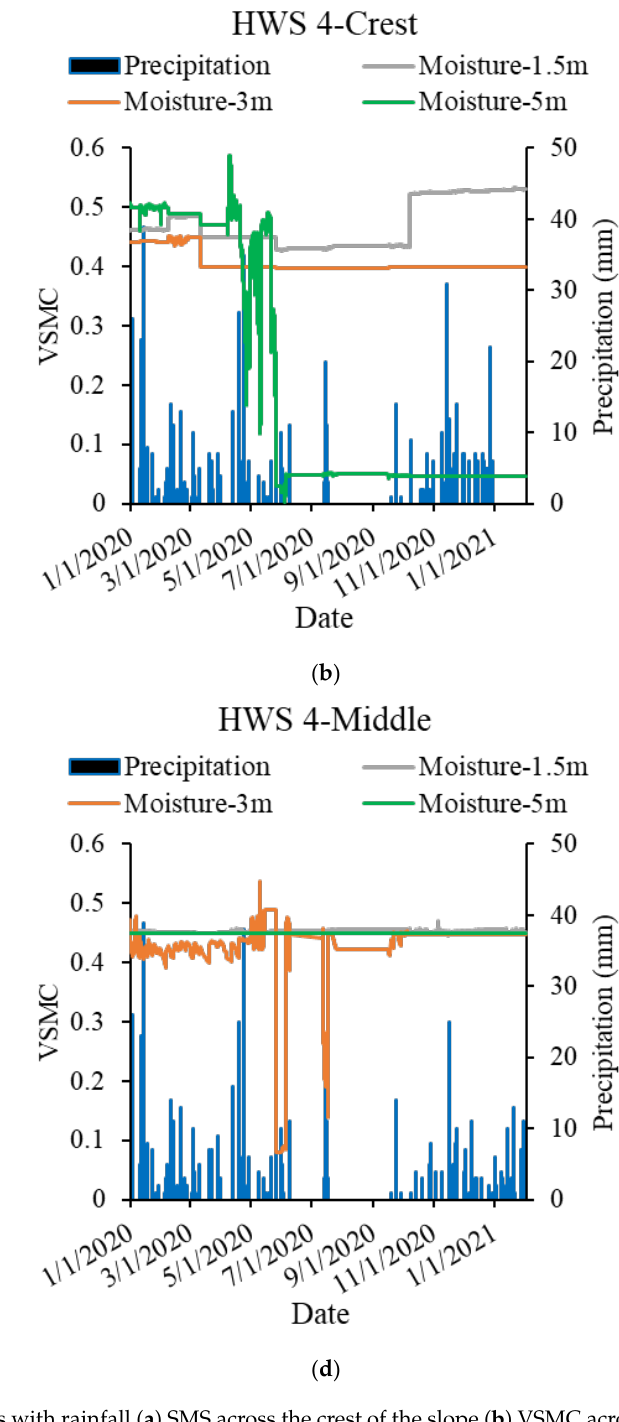
Figure 21. HWS 4 in situ variations with rainfall ( a ) SMS across the crest of the slope ( b ) VSMC across the crest of the slope ( c ) SMS across the middle of the slope ( d ) VSMC across the middle of the slope (1 m = 3.28 ft; 1 mm = 0.039 in; 1 kPa = 20.89 psf).